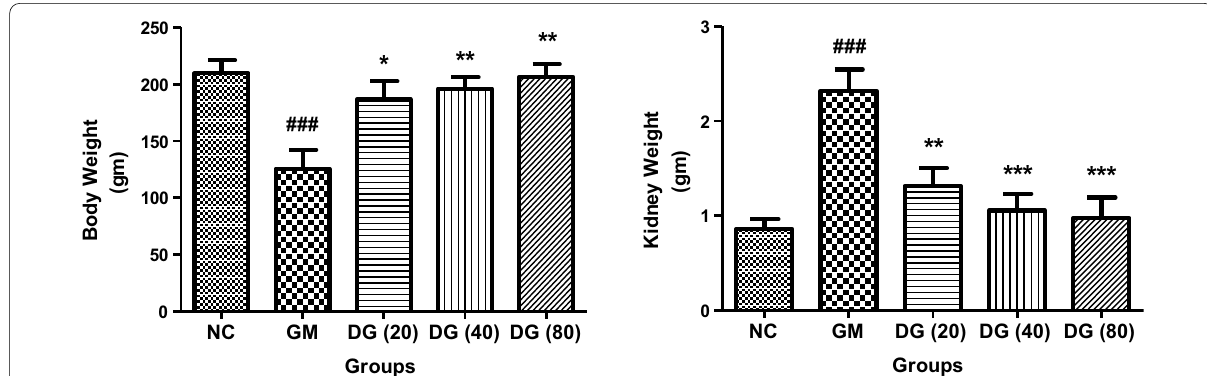
Fig. 5 Effect of DG on body weight and kidney weight (gm) in GM induced renal damage in rats. Values expressed as Mean ### p < 0.001 as compared to NC rats and * p < 0.05, ** p < 0.01 as compared to the GM group